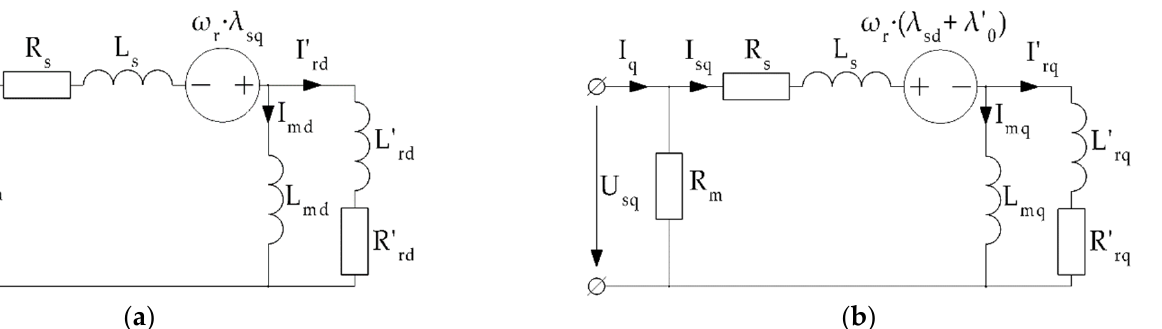
Figure 2. A d-q reference-frame-equivalent circuit of an LSPMSM motor: ( a ) d-axis; ( b ) q-axis. The motor starts as an asynchronous motor due to the torque of the squirrel cage (the corresponding elements L (cid:48) rd , L qd (cid:48) , R (cid:48) rd , and R (cid:48) rq ), overcoming the load torque and the oppositely directed torques of the permanent magnets and of the magnetic anisotropy, which generate the electric power at a frequency not equal to the frequency of the